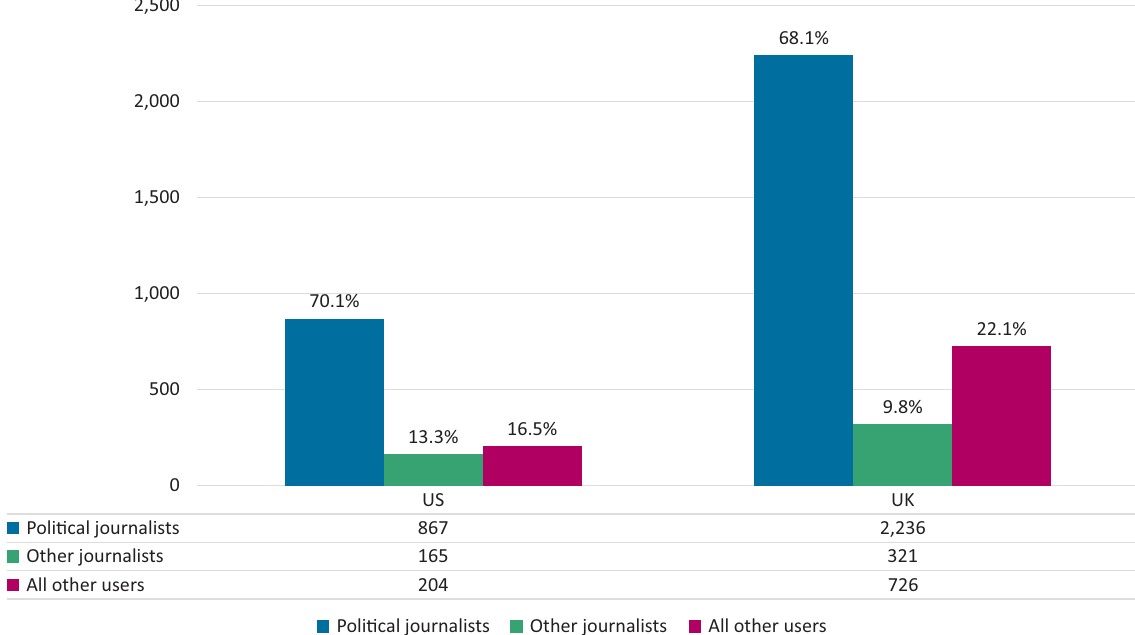
Figure 2. Political journalists’ preferred discussion partners in